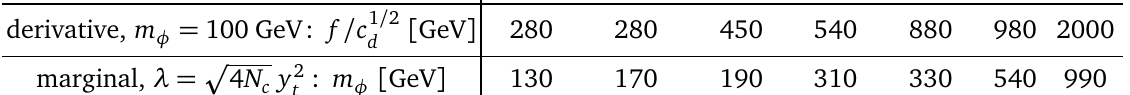
Table 2: 95% CL exclusion limits obtained from our off-shell Higgs analysis. See Sec. 3 for